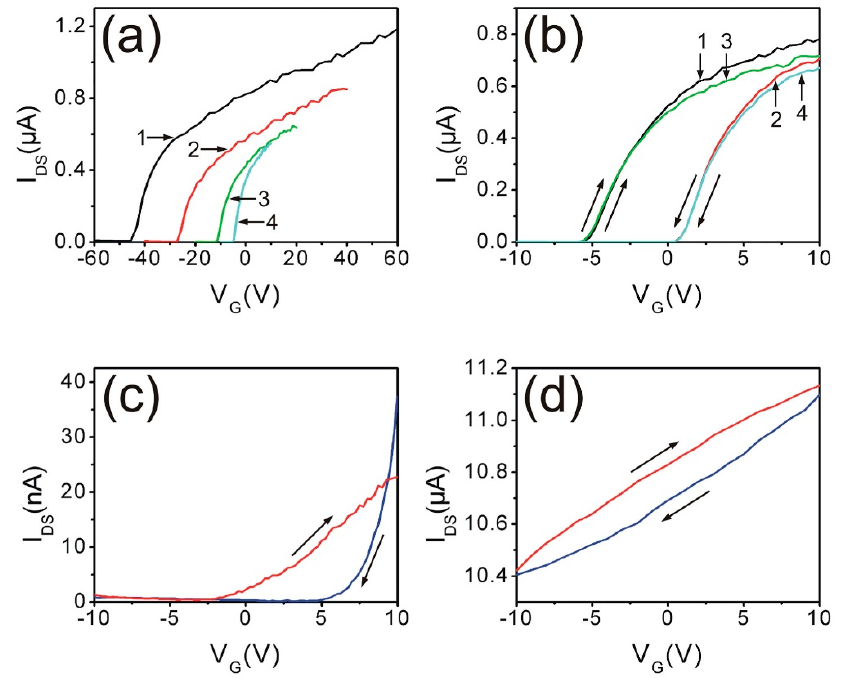
Figure 2. Gate voltage (V G )-dependent, 1 V source-drain bias, source-drain current (I ds (V G ) of ZnO nanowire FET under ambient conditions for I ds (V G ) sweep ranges ( a ) ± 60 V, ± 40 V, ± 20 V, and ± 10 V for sweeps labelled 1–4, respectively. ( b ) sweep range ± 10 V for a doped and ( c ) undoped nanowire, and ( d ) the latter in high vacuum. Reprinted with permission from American Institute of Physics [21].